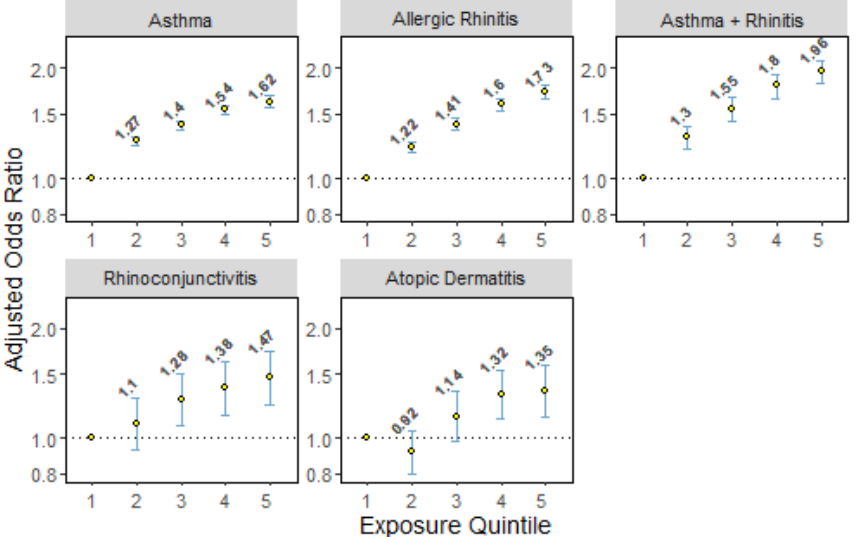
Figure 2. Odds ratios and 95% confidence intervals for exposure to NOx and atopic diseases, adjusted for year of birth, census SES, and school religious orientation. n = 2,311,240, n cases: asthma 140,166; allergic rhinitis 109,807; asthma with comorbid allergic rhinitis 37,311; rhino-conjunctivitis 9,452; atopic dermatitis 11,415. 1 = lowest NOx exposure category (<5.63 ppb), 2 = (5.63–10.5 ppb), 3 = (10.5–14.7 ppb), 4 = (14.7–19.1 ppb) and 5 = >19.1 ppb). When stratifying the study population by the decade of birth, we found that the shape of the exposure-response curve between NOx and asthma remained similar in all periods (Figure 3). The weakening of the associations in the last two periods may be a result of the varying absolute levels of the exposure quintiles. In addition, the associations of NOx with asthma, allergic rhinitis, or both were stronger in males vs. females (Figure 4). Finally, the association with asthma was stronger in the lower SES quintile than all other quintiles (Figure 5).